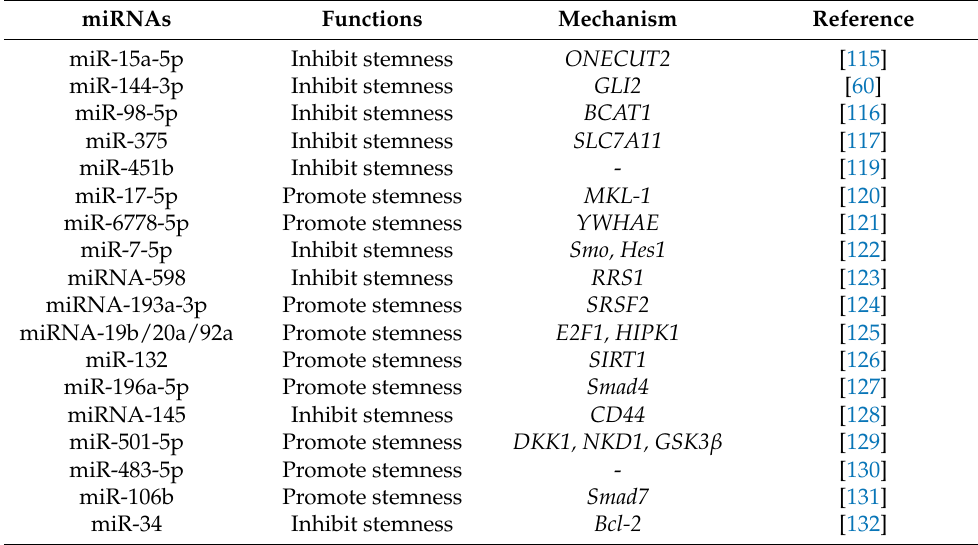
Table 3. Related miRNAs in